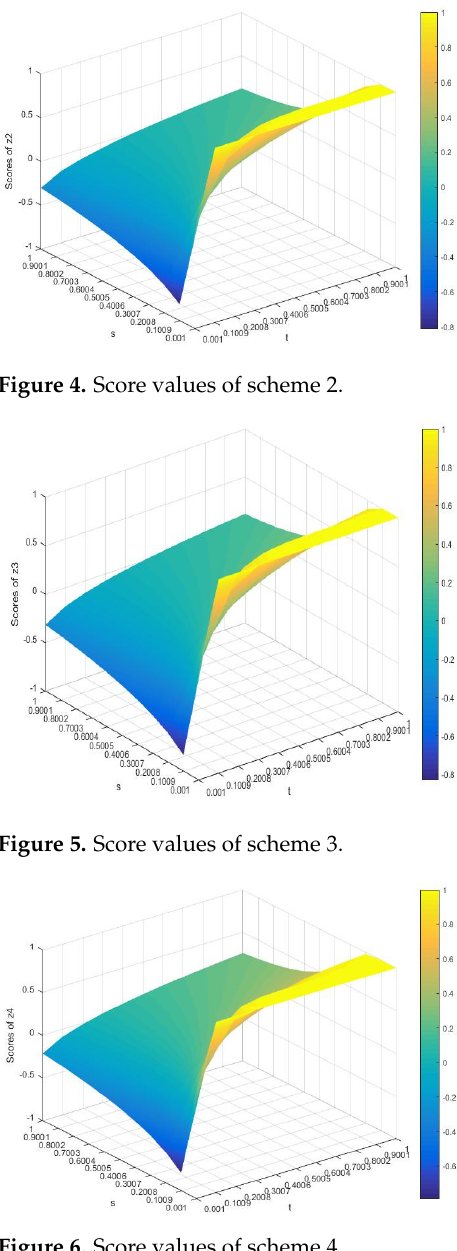
Figure 6. Score values of scheme 4.